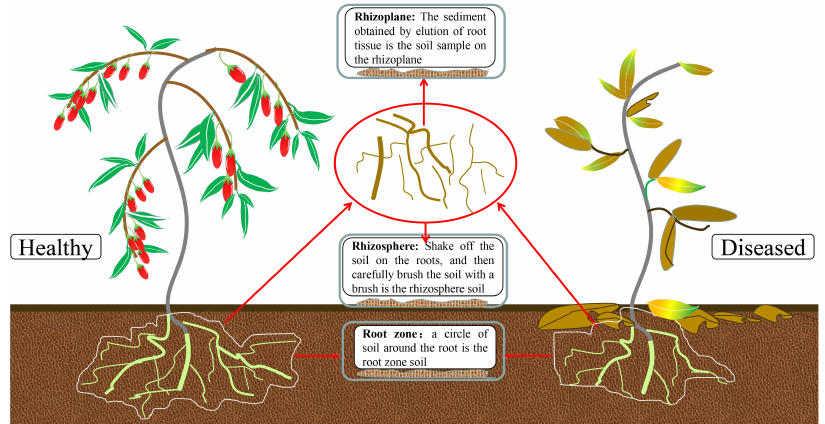
Figure 2. Diagram of sample collection.